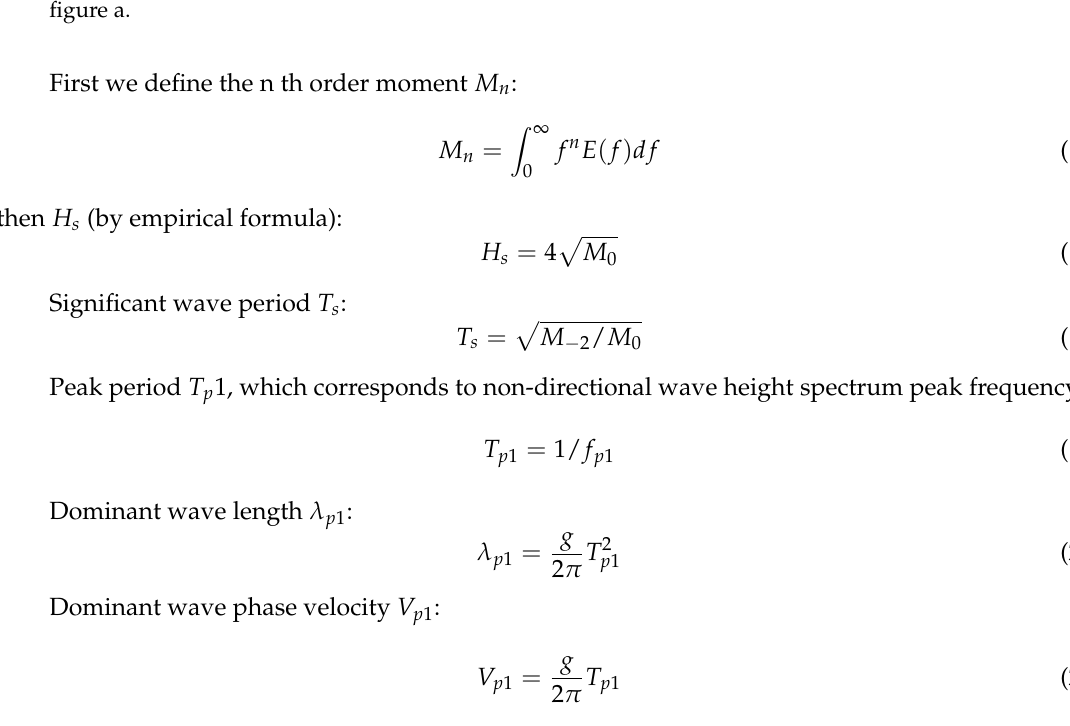
Figure 6. Doppler frequency shift spectra of all cells and Doppler velocity of all cells with range resolution of 7.5 m. ( a ) Doppler frequency shift spectra of all range cells. Data used are acquired with No.4 antenna at 04:05 25 March 2015. ( b ) Directional velocity of all range cells corresponding to figure